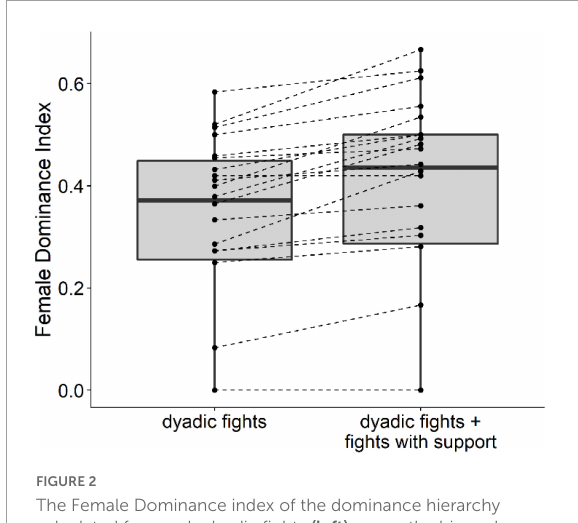
FIGURE2 The Female Dominance index of the dominance hierarchy calculated from only dyadic fights (left) versus the hierarchy with the inclusion of fights with support (right) . Note that support was seldom received from more than one individual (23 cases from 239 cases; from two or more females in 5 cases, from two or more males in 8 cases, and from two or more individuals of both sexes in 6 cases, in 2 cases, support was received from a coalition of a female and unidentified juveniles, and in 2 cases from a coalition of a male and unidentified juveniles). In 26 cases in which a female received support in an intersexual fight the sex of the supporter could not be identified.